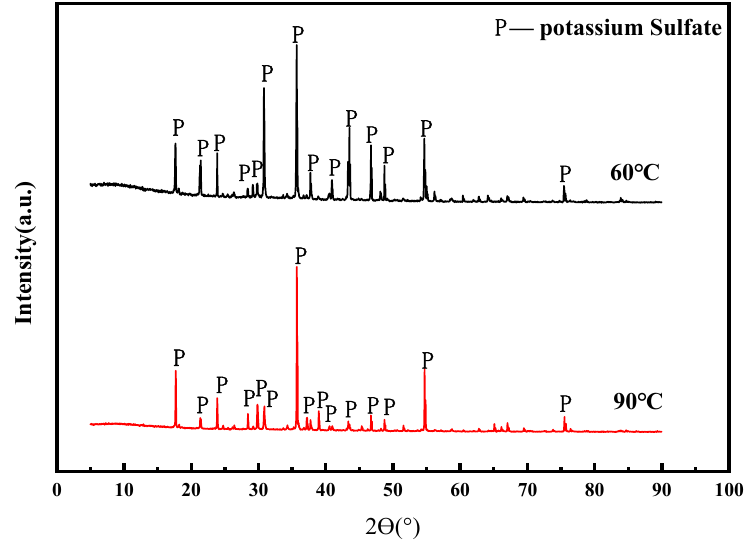
Figure 8. XRD spectra of the crystallized products of leaching at 60 ◦ C and 90 ◦ C (washing time 30 min, liquid-to-solid ratio 20).